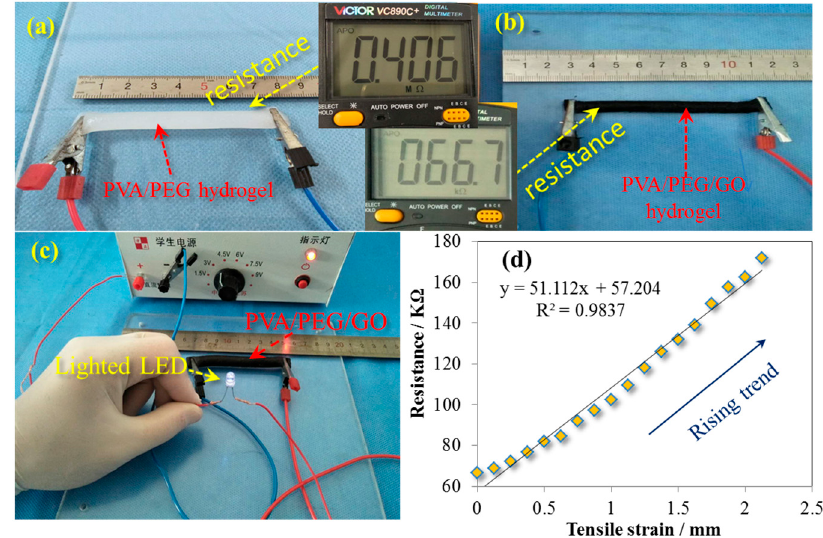
Figure 6. Conductive properties of ( a ) cylindriform PVA/PEG hydrogel; and ( b ) PVA/PEG/GO hydrogel; ( c ) a demo on lighting an LED lamp using PVA/PEG/GO hydrogel with such a high resistance; and ( d ) the relationship of gel electrical resistance and gel tensile strain under uniaxial stretching.